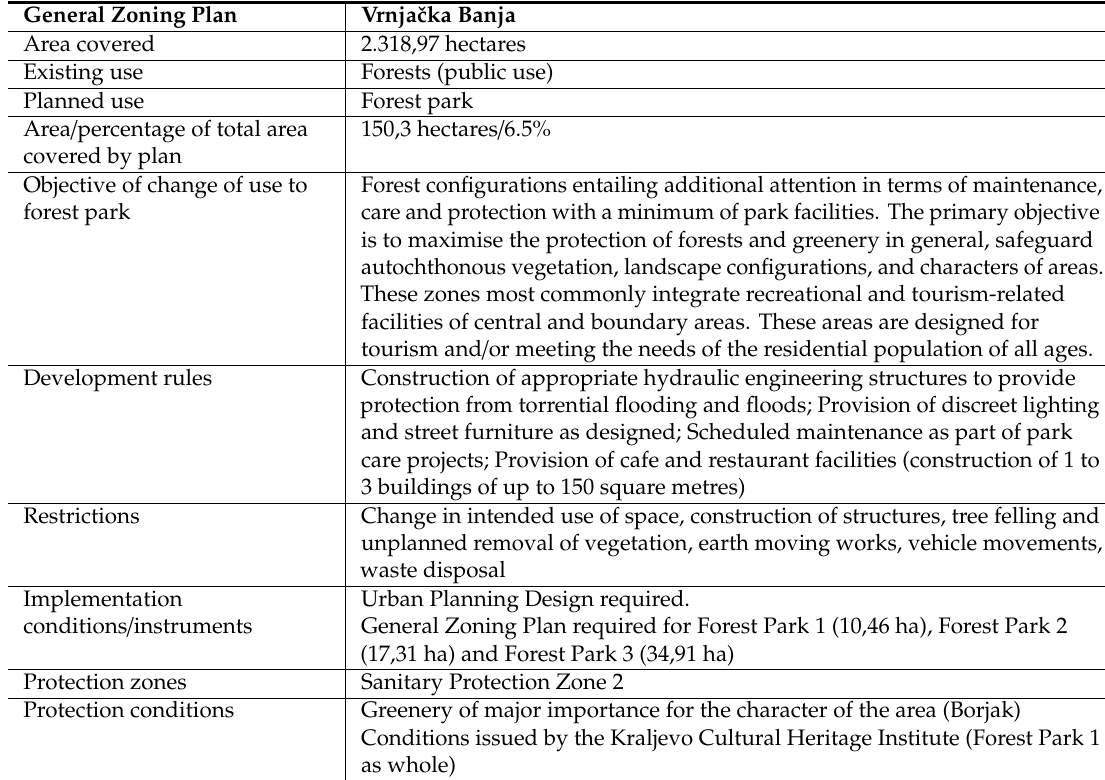
Table 3. General Zoning Plan for Vrnjaˇcka Banja: aspects relevant to land use planning related to urban forest